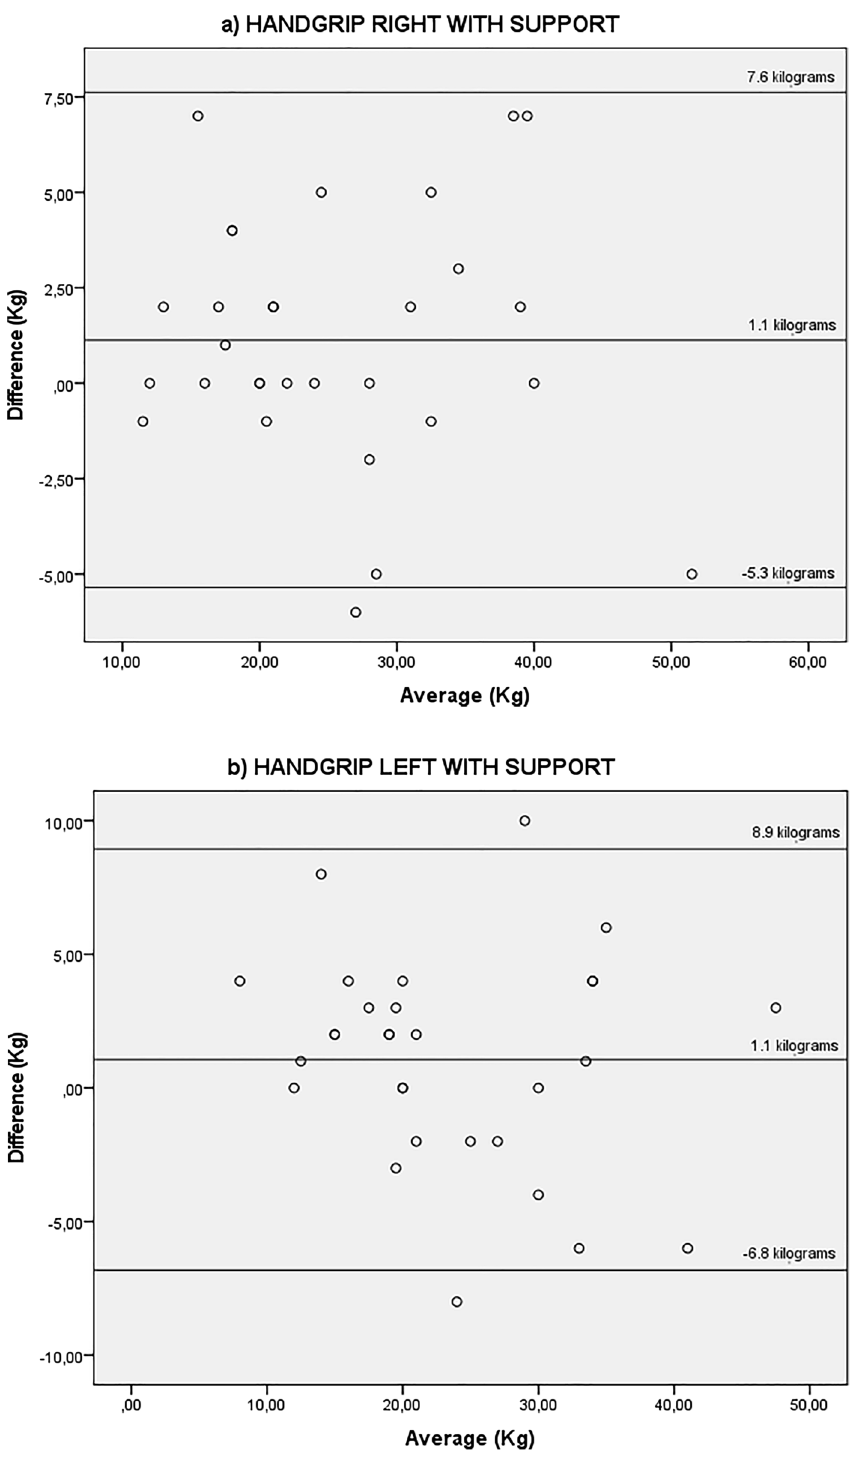
Figure 4. Bland–Altman plots showing agreement for the kilograms achieved with the handgrip strength test, right and left with forearm supported, obtained before the haemodialysis session and on a non-dialysis day by the same rater. Y axis difference between (non-dialysis—before the haemodialysis session) Kilograms X axis average (non-dialysis + before the haemodialysis session)/2